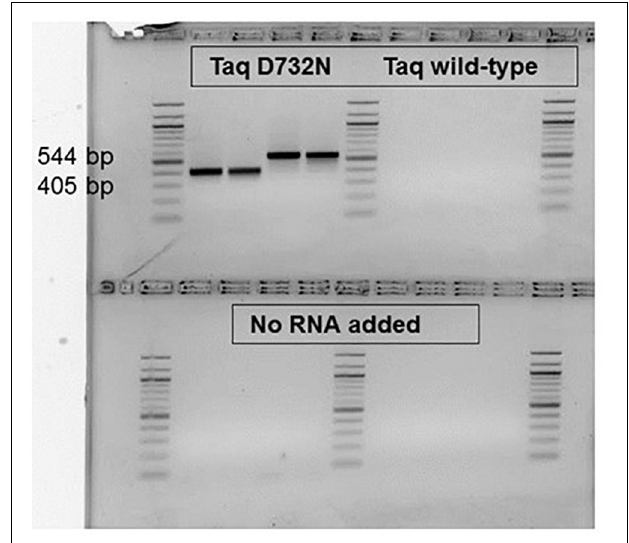
FIGURE 5 | RT-PCR catalyzable by single enzyme Taq D732N but not wild-type Taq. No reverse transcriptase was included, nor was any manganese ion. Two MS2 phage RNA targets, P and K were amplified from 5 pg phage RNA with 0.1 or 0.05 µ l D732N mutant or twice as much volume of wild-type Taq (NEB) in 35 µ l reactions for 35 PCR cycles. The amplified products were run in a 2.5% agarose gel stained with ethidium bromide, along with a 100 bp DNA ladder (white/black reversed for clarity as printed). As negative control, no RNA was included for the reactions analyzed on the bottom half of the gel. The size of the clearly and successfully amplified bands are 405 and 544 bp (primer-primer gap sizes 359 and